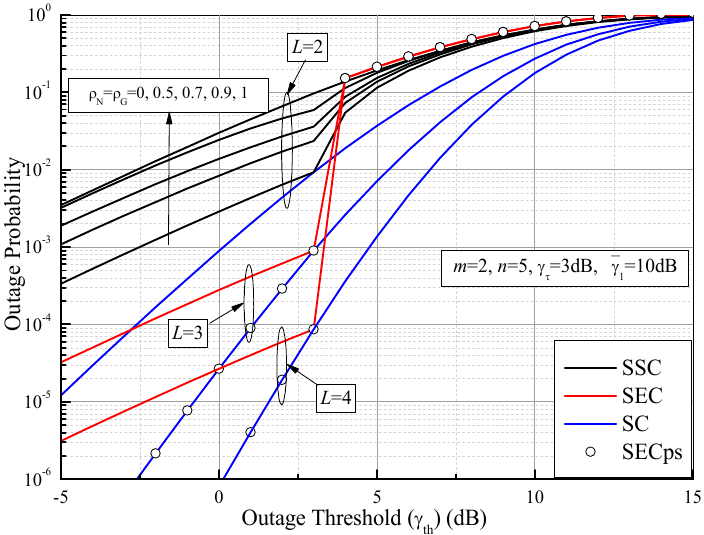
Figure 5. Outage probability values of different switched diversity systems as functions of the outage threshold ( γ th ) over Fisher–Snedecor F fading channels with m = 2, n = 5, γ 1 = 10 dB, and γ τ = 3 dB